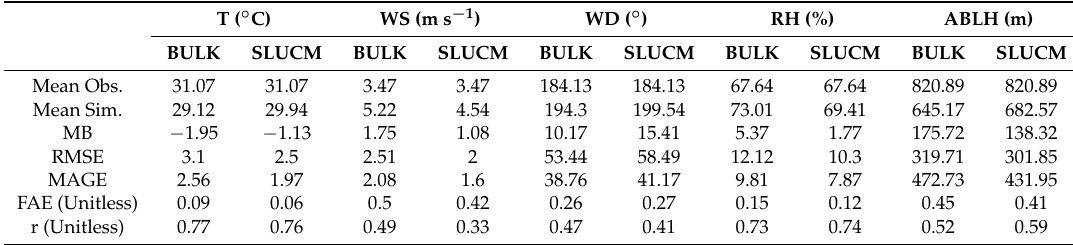
Table 5. The mean statistical parameters of four sites between the measured and the simulated 2-m air temperature (T), wind speed (WS), wind direction (WD), relative humidity (RH), and ABL height (ABLH, station s2 measured data only) on 1–8 July 2011. T ( ◦ C) Mean